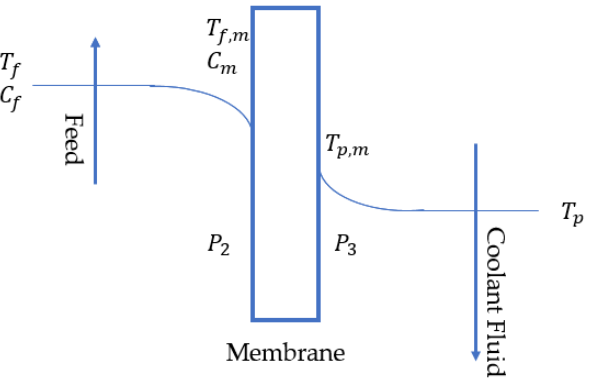
Figure 2. Temperature gradient in a direct contact membrane distillation system [12].